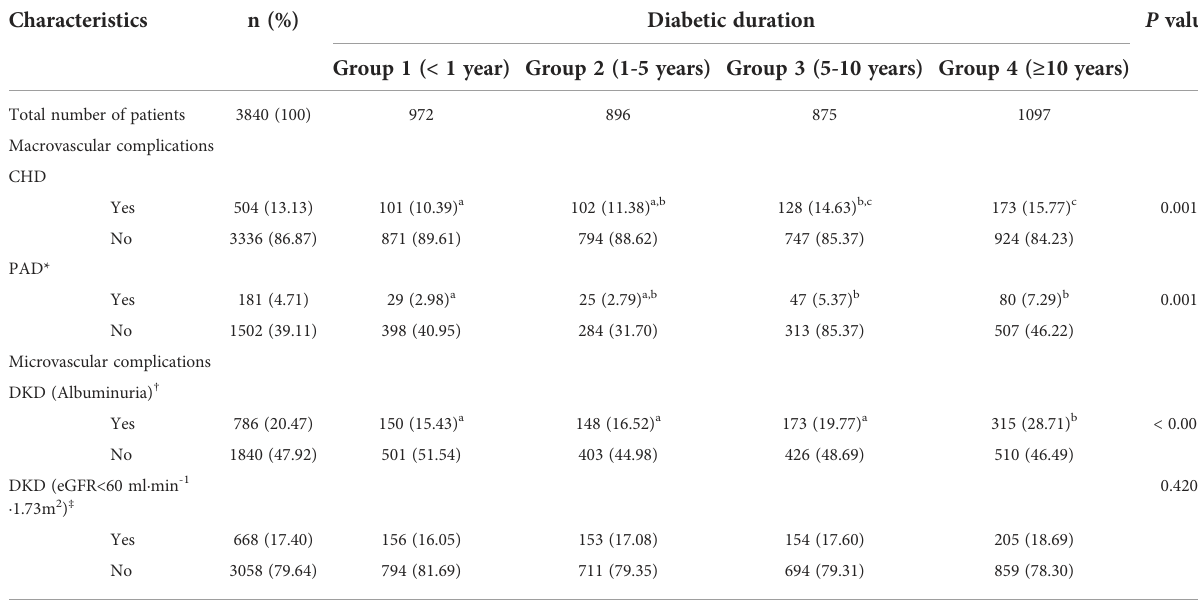
TABLE 4 Characteristics of elderly T2DM patients with diabetic complications. Characteristics